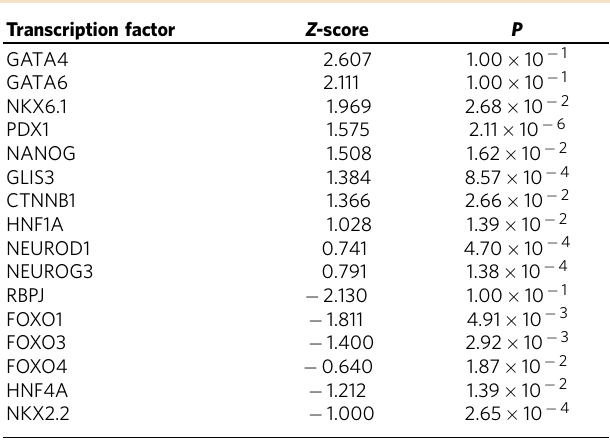
Z -score analysis of transcriptional networks involved in pancreas development in ALDH þ